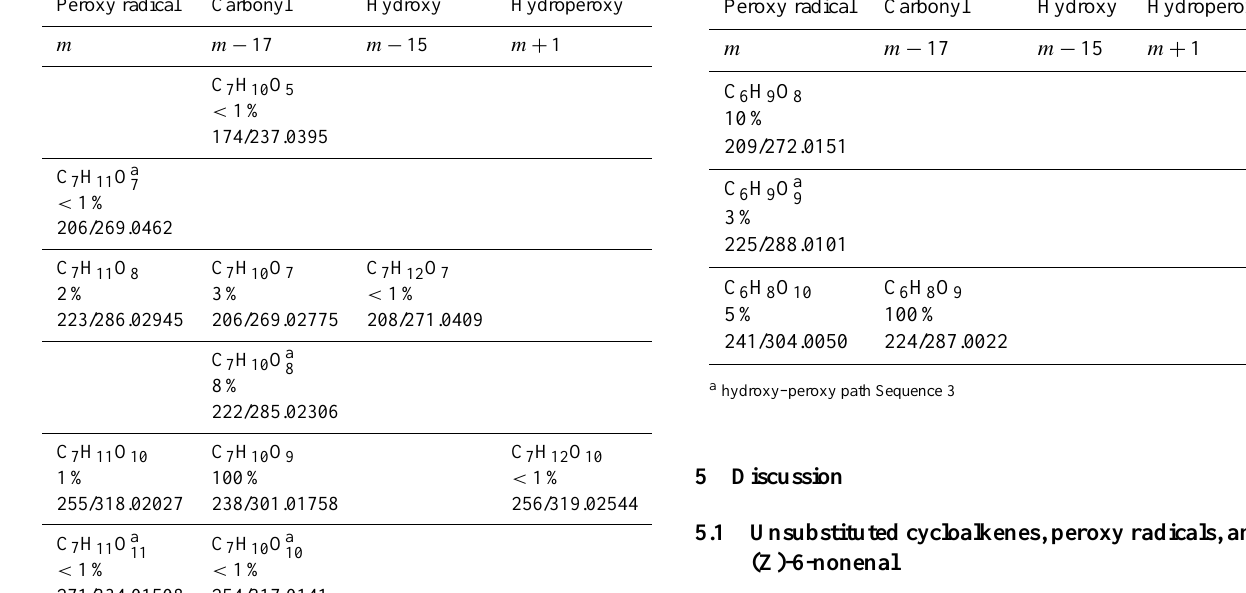
Table 6. HOM observed during ozonolysis of cycloheptene. The Table 7. HOM observed during ozonolysis of (Z)-6-nonenal. The second header line shows at which molar masses the termination second header line shows at which molar masses the termination products are expected relative to the peroxy radical with molar mass products are expected relative to the peroxy radical with molar mass m (unit masses). Filled cells indicate that these compounds were de- m (unit masses). Filled cells indicate that these compounds were de- tected with given elemental composition and relative intensity (sec- tected with given elemental composition and relative intensity (sec- ond line in the same cell). Relative intensities were normalized to ond line in the same cell). Relative intensities were normalized to the largest HOM signal. The third line in the cell gives the molar the largest HOM signal. The third line in the cell gives the molar mass [Da] in unit mass resolution and the precise m/z [Th] at which mass [Da] in unit mass resolution and the precise m/z [Th] at which the molecule was detected as cluster with 15 NO − . the molecule was detected as cluster with 15 NO − 3 3 Peroxy radical Carbonyl Hydroxy Hydroperoxy